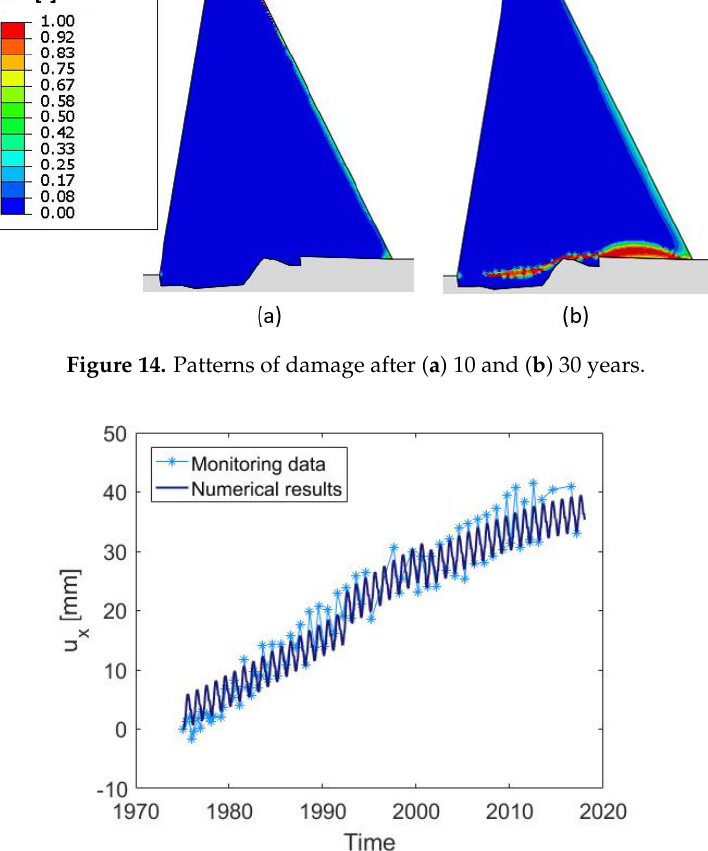
Figure 15. Comparison between monitoring data and numerical results, in terms of horizontal crest